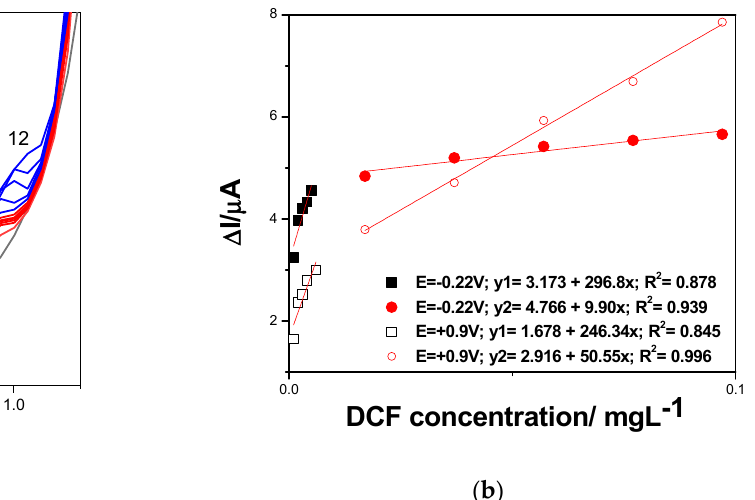
Figure 6. ( a ) Square-wave voltammograms recorded on GR-CNT electrode in 0.100 M Na 2 SO 4 supporting electrolyte (curve 1) and in the presence of various DCF concentrations: curves 2–11: 0.001–0.010 mg·L − 1 DCF; step potential of 50 mV; modulation amplitude of 200 mV, frequency of 2 Hz, potential scan rate: 100 mV·s − 1 ; potential range: − 0.500 to +1.50 V vs. Ag/AgCl. ( b ) Calibration plots of the currents recorded at E = − 0.220 (filled symbols), and E = +0.900 V (unfilled symbols) vs. Ag/ AgCl, versus DCF